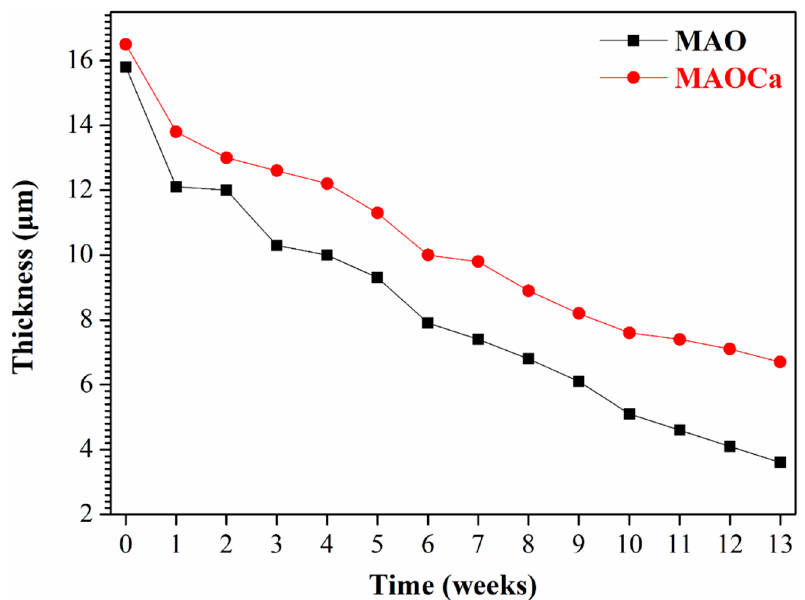
Figure 5. Thickness measurements for the MAO- and MAOCa-coated ZK60, recorded once every week during long-term immersion in SBF solution.